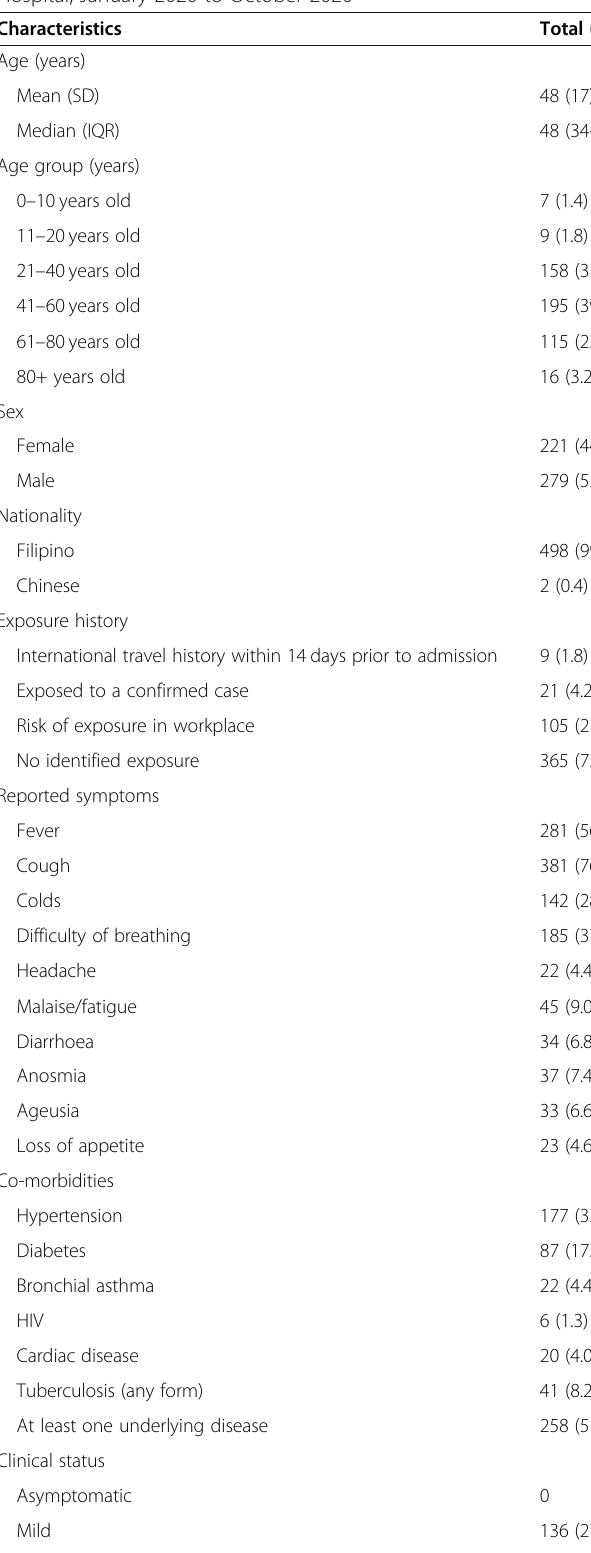
Table 1 Epidemiologic and clinical characteristics of healthcare and non-healthcare workers COVID-19 inpatients in San Lazaro Hospital, January 2020 to October